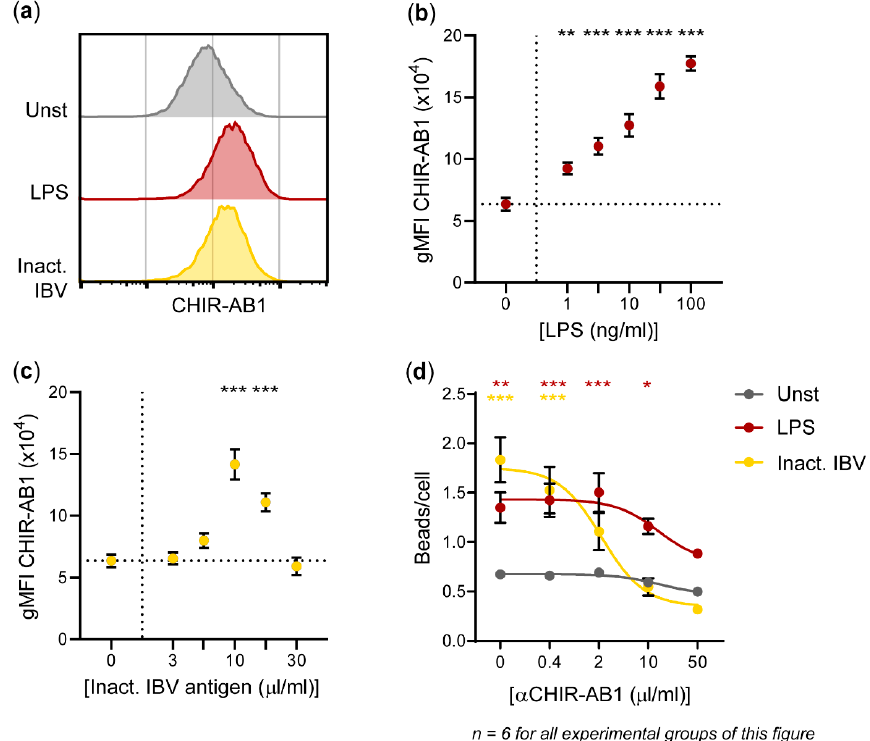
Figure 5. The induction of phagocytosis after exposure to inactivated IBV antigen is dependent on the IgY Fc receptor CHIR-AB1. ( a ) Representative histograms show CHIR-AB1 expression by HD11 cells after 24 h without stimulation, stimulation with 100 ng / mL LPS, or stimulation with 10 µ L / mL IBV antigen. ( b , c ) CHIR-AB1 surface expression by HD11 cells was quantified and expressed as the geometric mean fluorescent intensity (gMFI) after 24 h stimulation with di ff erent concentrations of LPS ( b ) and IBV antigen ( c ). ( d ) Unstimulated HD11 cells and HD11 cells stimulated with LPS or inactivated IBV antigen for 24 h received the blocking antibody 8D12 specific for chicken CHIR-AB1 10 min before the addition of IgY-opsonized beads. The average number of phagocytosed beads per HD11 cell is shown for di ff erent concentrations of blocking antibody. Three independent experiments were performed, and the experimental conditions of each independent experiment were tested in duplicate. Error bars represent the SEM. The experimental groups were tested for statistically significant di ff erences in CHIR-AB1 expression or bead uptake between stimulated and unstimulated groups using one-way ANOVA tests and Holm–Sidak’s multiple comparisons tests. Statistical significance is indicated by * p < 0.05, ** p < 0.01, and *** p <